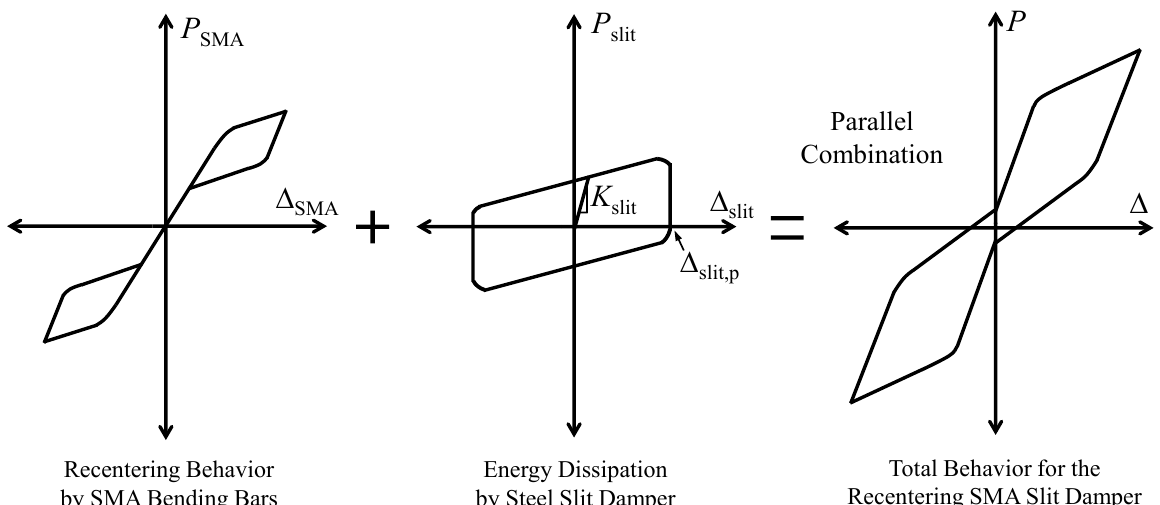
Figure 6. Response mechanism of the recentering slit damper